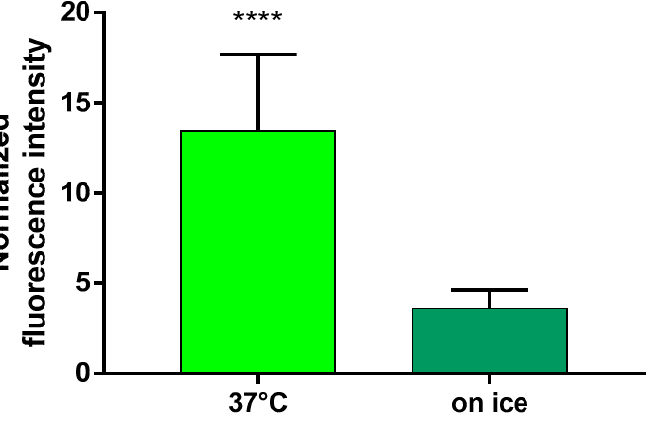
Figure 9. Uptake of FITC-HPBCD by hCMEC/D3 cells. Fluorescence intensity values of the samples are normalized to the value of the untreated control and presented as means ± SEM. Statistical analysis: unpaired t test with Welch’s correction (two-tailed p value). **** p < 0.0001, n = 12 for ’37 °C’ and n = 13 for ’on ice’.